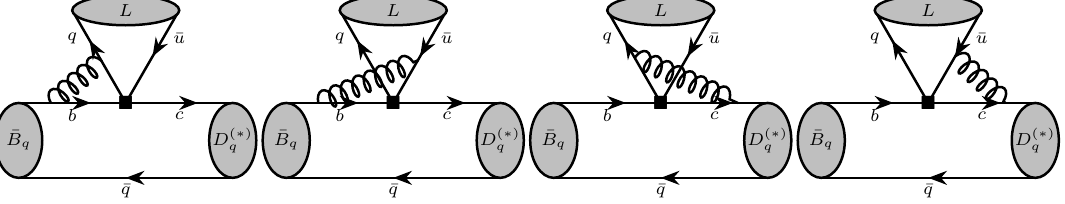
Figure 3 . “Non-factorizable” vertex corrections to the hard kernels T ij ( u ) at the NLO in α s , where the other captions are the same as in figure